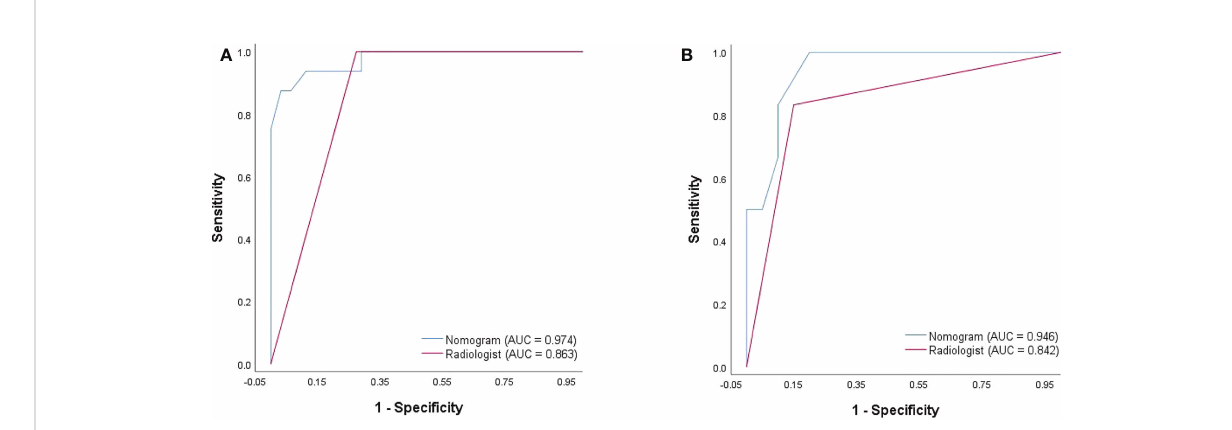
FIGURE 5 ROC curves of the nomogram and the radiologist ’ s diagnosis derived from the training cohort (A) and the validation cohort (B)